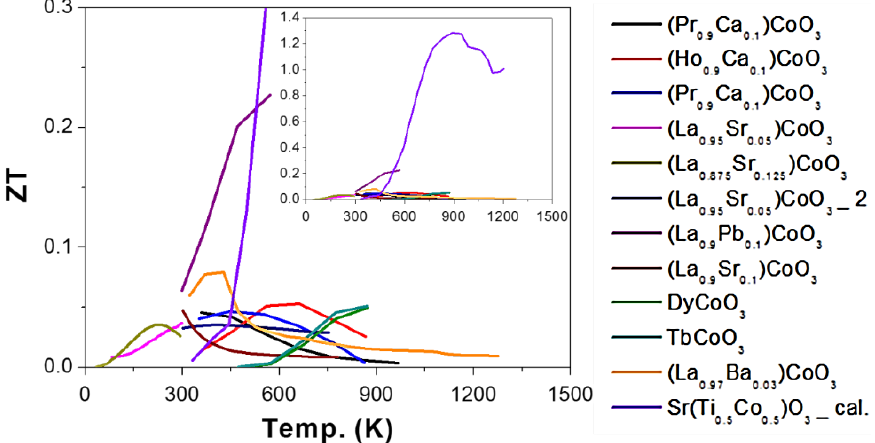
Figure 8. ZT value of ACoO 3 based oxide perovskite materials, all the materials are p-type semiconductors. The symbol “cal.” means the results come from the calculation.